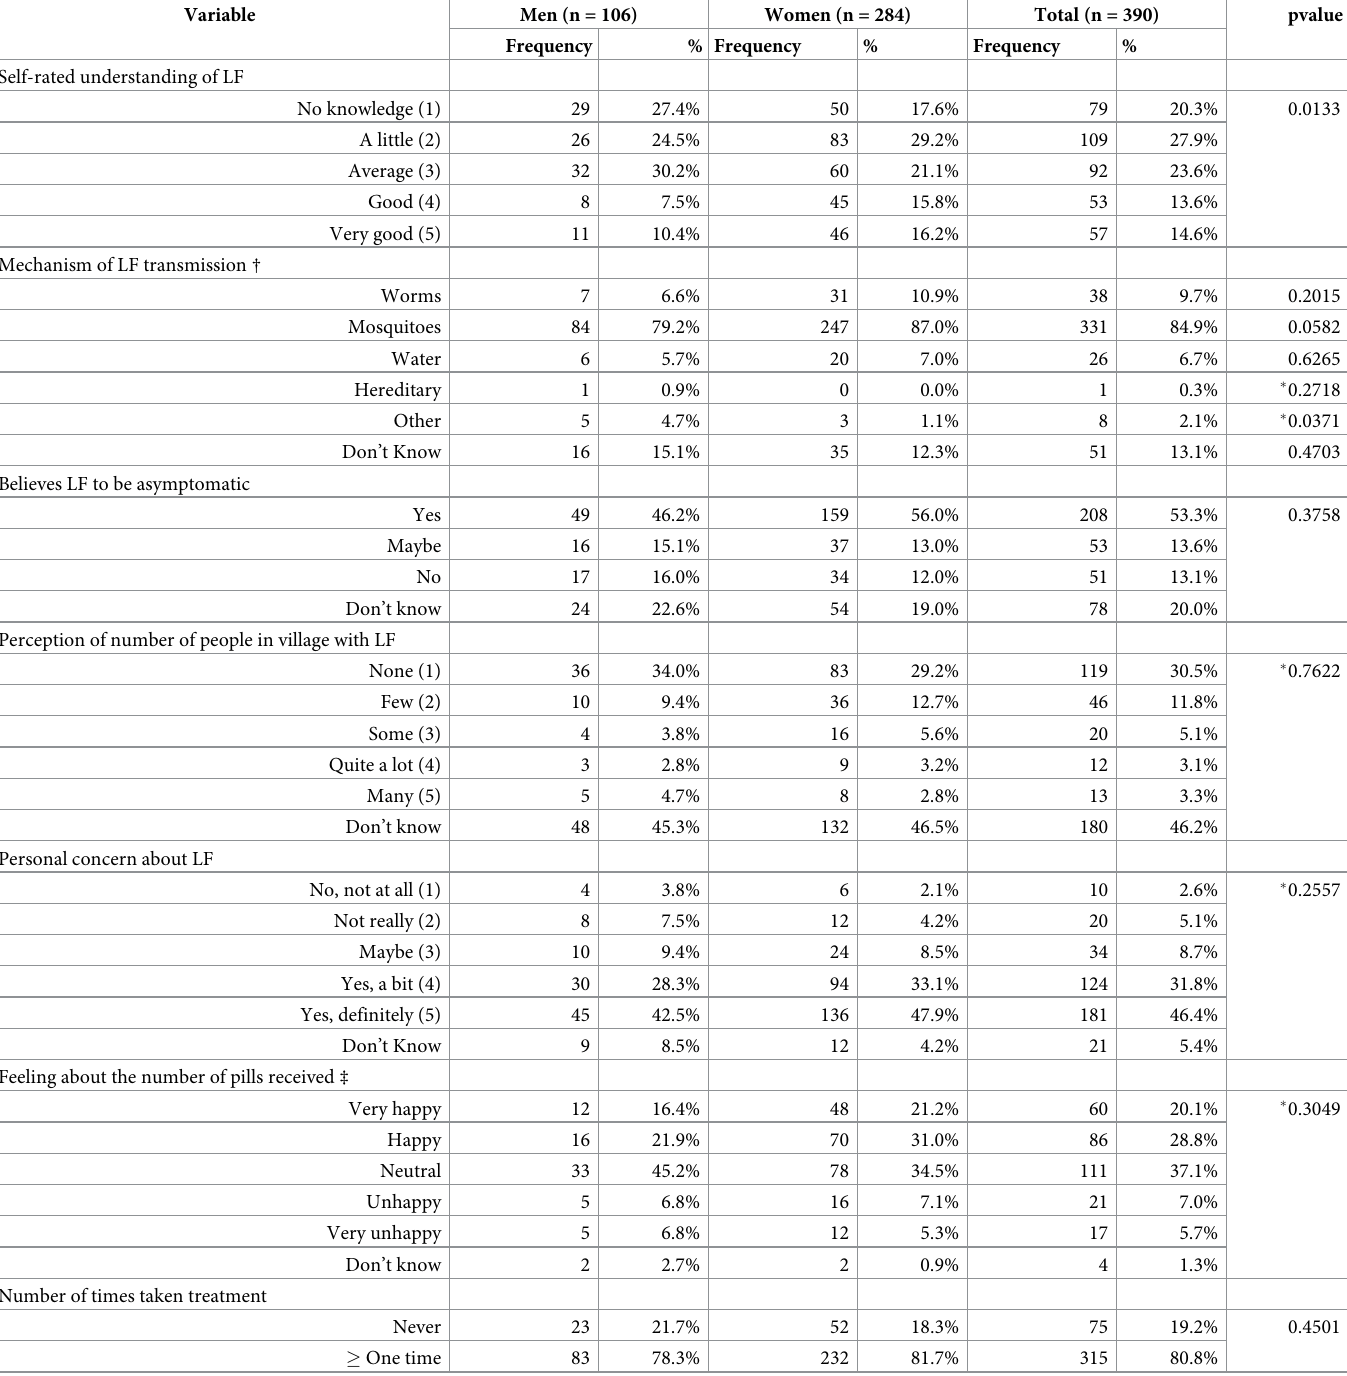
Table 4. Descriptive analysis of key variables by sex in the primary study